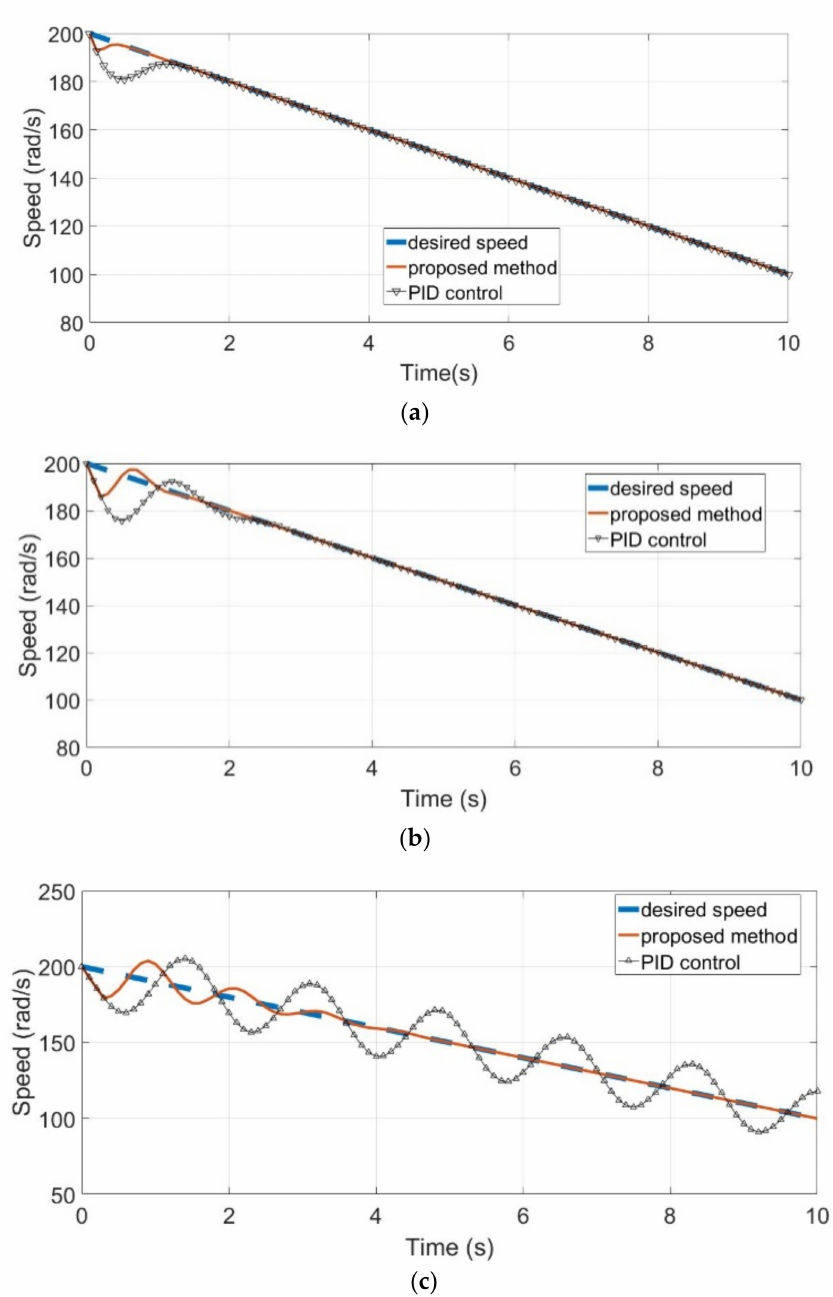
Figure 13. The simulation results with different braking control methods during the normal braking process ( a ) input time-delay is 0.1 s ( b ) input time-delay is 0.2 s ( c ) input time-delay is 0.3 s